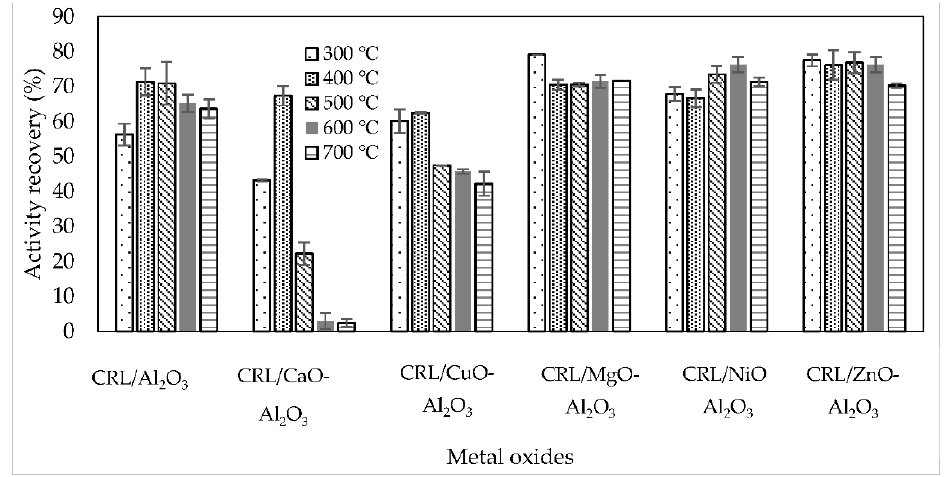
Figure 2. Effect of different calcination temperatures of MO-Al 2 O 3 towards activity recovery. CRL/MgO-Al 2 O 3 showed the highest activity recovery obtained of 79.11%, when calcined at 300 °C. After 500 °C, the activity recovery dropped, resulting from the lost hydroxyl groups on temperature treatment, thus, decreasing enzyme immobilization on the support. In the case of CRL/ZnO-Al 2 O 3 , no significant difference was observed by varying calcination temperature, yielding 70.34% in the lowest activity recovery when calcined at 700 °C. In addition, the highest activity recovery for CRL/NiO-Al 2 O 3 was 76.31% when the carrier was calcined at 600 °C and decreased afterwards. Because of the weak interaction between NiO and Al 2 O 3 as the calcination temperature increased, there was more free Ni on the support surface and the Ni was more likely to migrate and aggregate, resulting in a decrease in adsorption capacity of CRL [29]. For CRL/ CuO-Al 2 O 3 , activity recovery for immobilized CRL increased when the support was calcined at 400 °C, resulting in 62.45% of activity recovery and the trend for activity recovery decreased when calcined > 400 °C. These results suggest that the calcination temperature changes the physiochemical properties of the MO-Al 2 O 3 and affects the activity recovery of the immobilized CRL. Based on the obtained results on activity recovery of immobilized lipase, 0.1:1 w/w of MgO: Al 2 O 3 ratio, calcined at 300 °C, was selected for optimization of CRL immobilization. 2.3. Optimization of CRL Immobilization Using RSM for Activity Recovery The optimization of immobilization parameters was performed using Box–Behnken Design (BBD). The coded values, experimental, and predicted values for activity recovery and immobilization yield are given in Table 1. Table 1. Experimental design for response surface design for CRL immobilization on MgO-Al 2 O 3 using BBD. Run Order Agitation Speed (rpm)